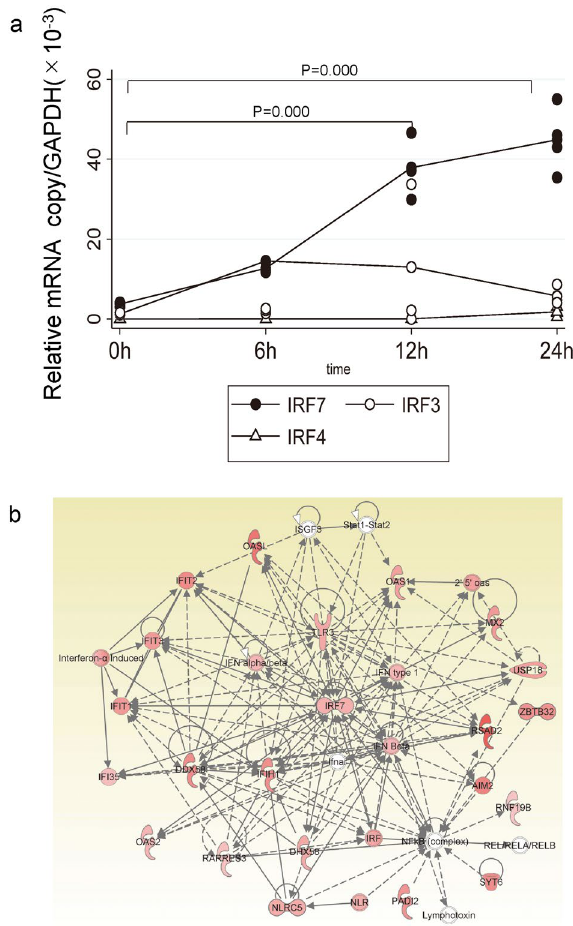
Figure 1. Induction of the expression of interferon regulatory factor 7 (IRF7) in corneal endothelial cells after herpes simplex virus 1 (HSV-1) infection. ( a ) The induction of the mRNA of IRF in human corneal endothelial (HCEn) cells after HSV-1 infection at multiplicity of infection (MOI) 1. IRF7 was induced 6 h post infection (PI), and a significant induction of IRF7 was maintained for 24 h PI. N = 4, ANOVA and Tukey test. ( b ) Network analysis of corneal endothelial cells after HSV-1 infection. IRF7 is centrally located in the highly significant primary network ( P = 10 –36 ). Ingenuity pathway analysis 2020 (QIAGEN Inc. accessed on July 2020, https:// digit alins ights. qiagen. com/ produ cts- overv iew/ disco very- insig hts- portf olio/ analy sis- and- visua lizat ion/ qiagen- ipa/) was used to generate the network